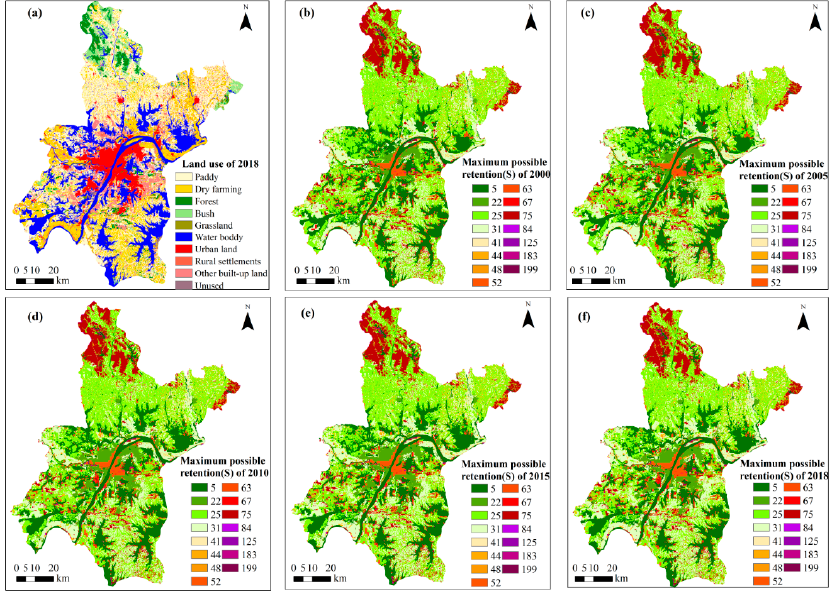
Figure 5. Spatiotemporal patterns of land use of 2018 ( a ) and standard derivation of elevation and maximum possible retention ( S ) in Wuhan (( b ) 2000, ( c ) 2005, ( d ) 2010, ( e ) 2015, ( f ) 2018).